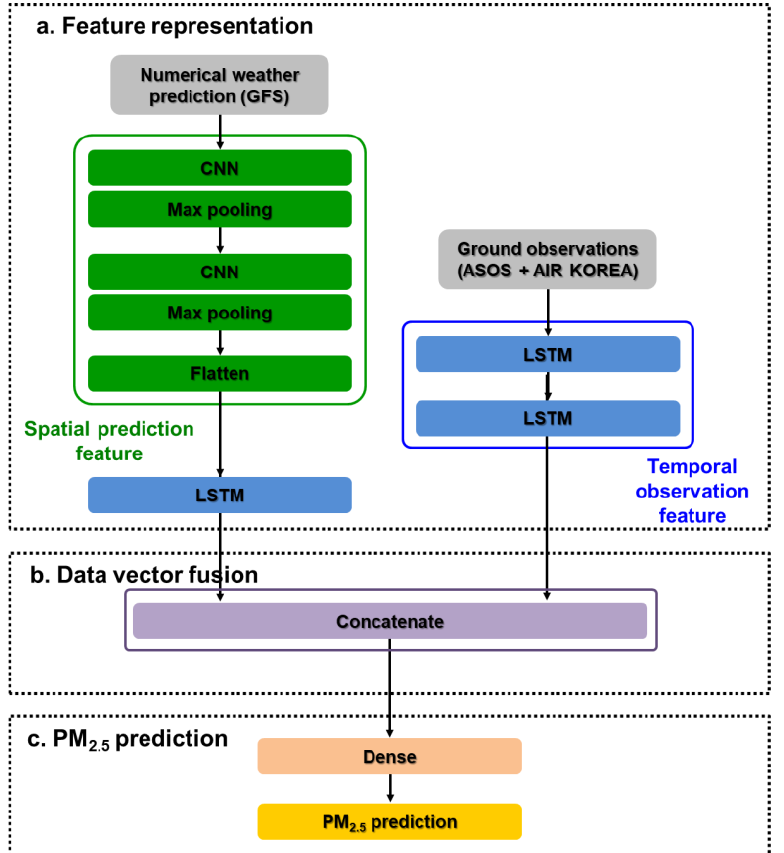
Figure 2. Flowchart of the CNN+LSTM hybrid ANN-based PM 2.5 prediction.